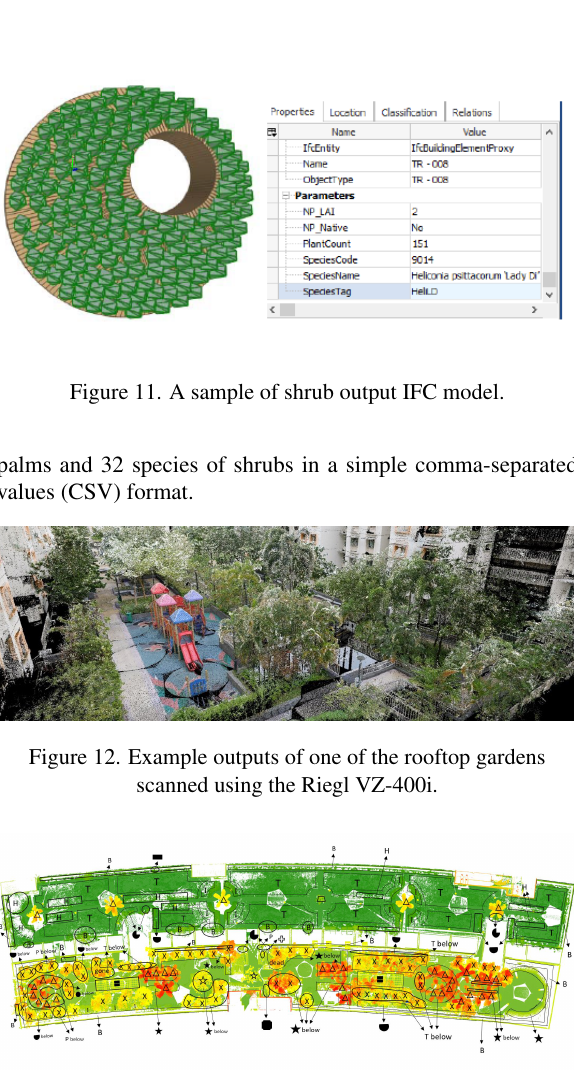
Figure 13. Individual species were identified using maps generated from the scans.